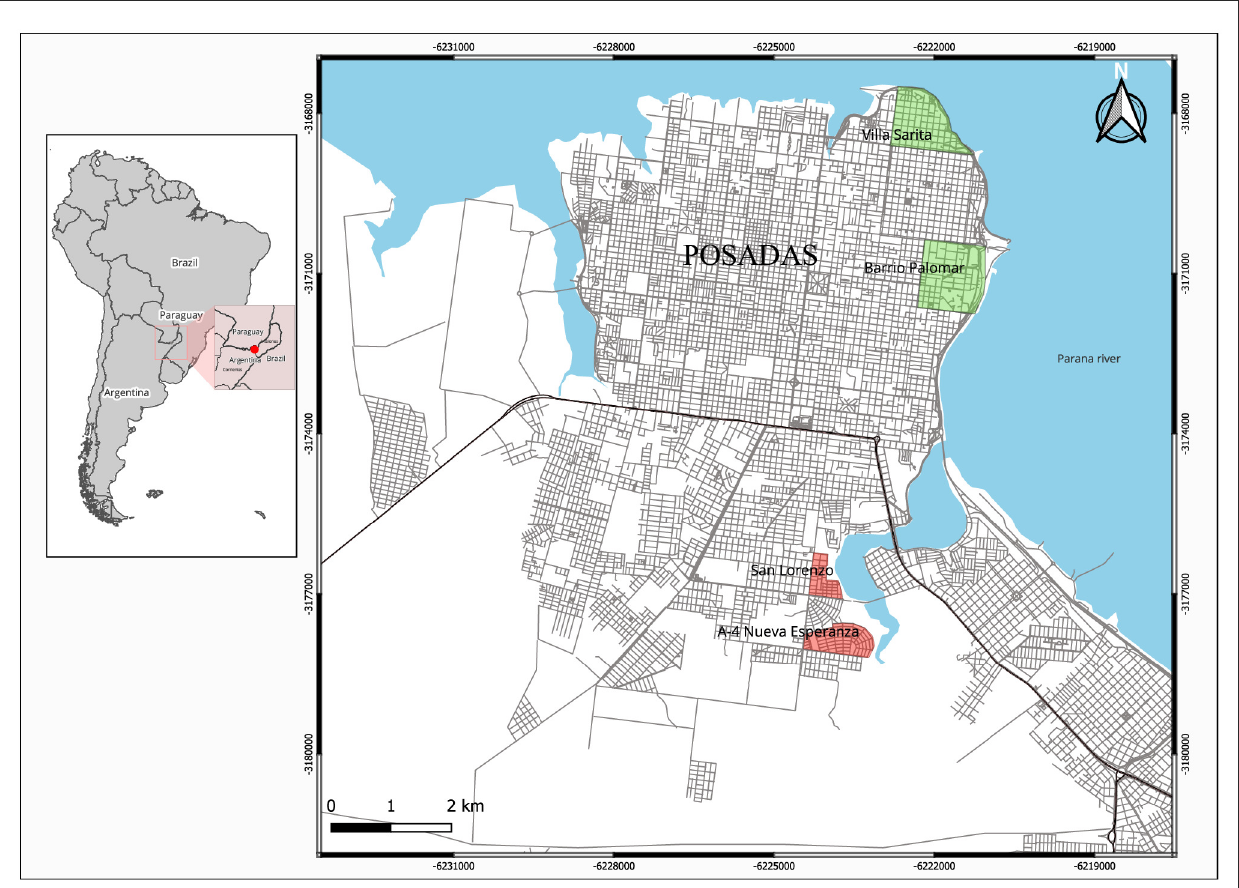
FIGURE1 Distribution of Aedes collection sites on low (red) and high (green) socio-economic status (SES) neighborhoods in Posadas, Argentina.